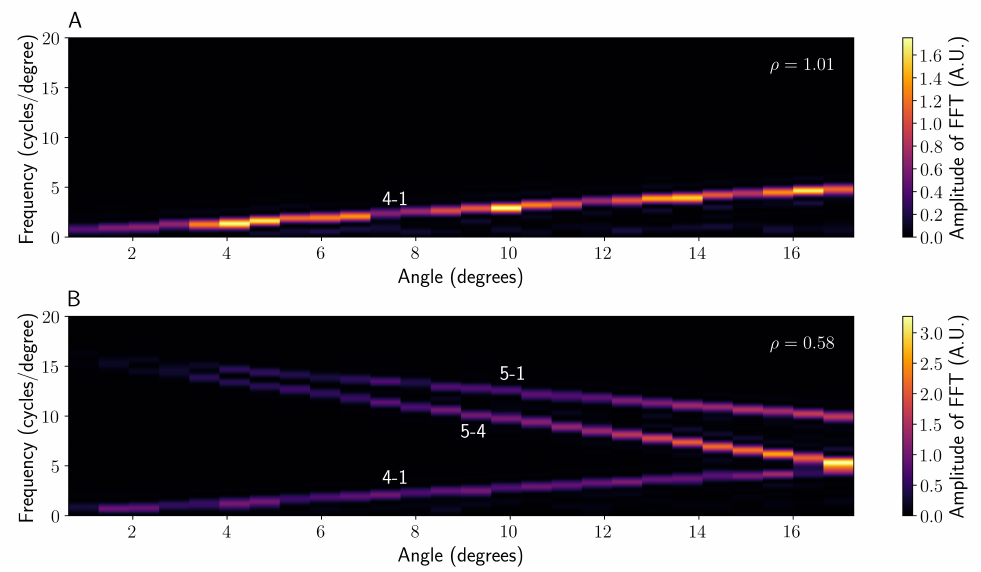
Figure 7. A spectrogram showing the rolling Fourier transform of the unchirped fringe pattern for both ρ > 1 ( A ) and ρ < 1 ( B ). Each distinct chirp rate α ij is labelled with the corresponding beams that constitute it, e.g., 4-1 is the interference between rays 4 and